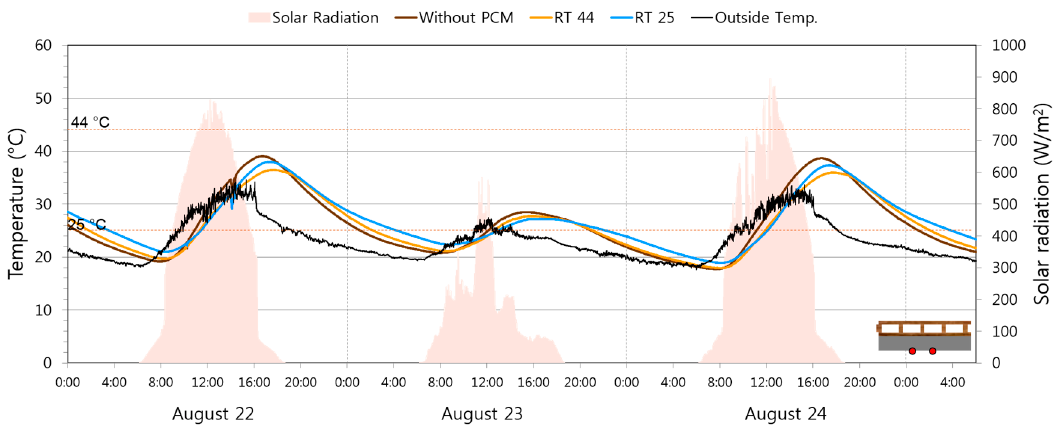
Figure 10. Chamber ceiling temperature in the plates with PCMs with different melting temperatures.